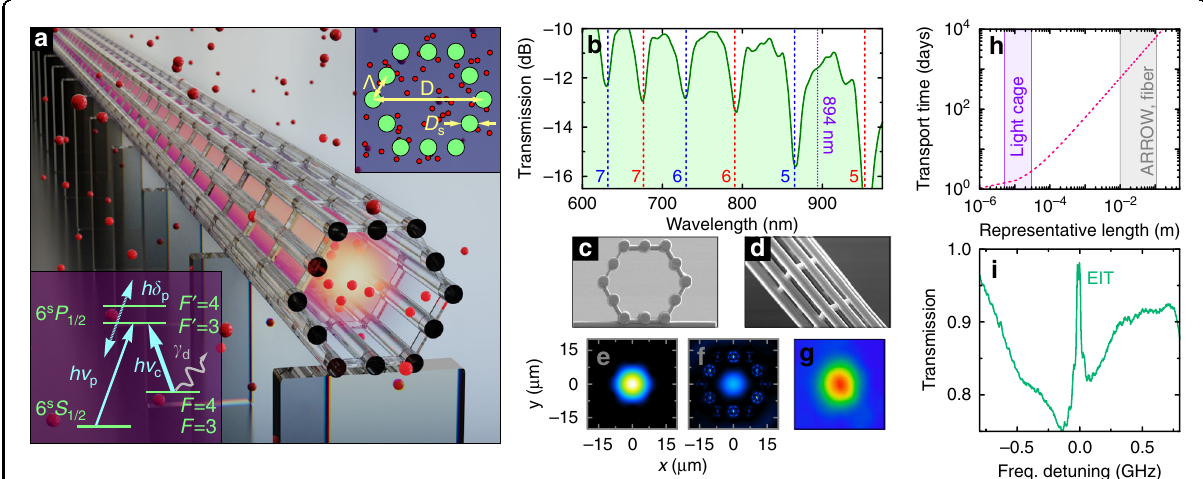
Fig. 1 Quantum-optically integrated light cage. a Sketch of the light cage (LC) enclosing a light beam (yellow) exposed to caesium (Cs) vapour (red spheres). Bottom inset: EIT Λ -scheme with probe ( ν p ) & coupling fi elds ( ν c ) and coherence dephasing γ d of the F = 4 hyper fi ne state. Top inset: cross section of the LC geometry including design parameters ( D s = 3.6 μ m, Λ = 7 μ m, D = 28 µm, and 4.5 mm length). b Transmission spectrum of the Cs-cell-integrated LC in the visible – near-infrared with the Cs-D1 line (894 nm) in a leaky mode between cut-off frequencies of isolated strand modes 38,39 (dashed lines, blue: LP 0x , red: LP 1x ). c Scanning-electron microscopic image of the LC front facet. d Side view of the sample, showing open spaces between strands. Simulated spatial fi eld distributions, e within a transmission band (894 nm) and, f near a resonance (930nm). g Measured output fi eld pattern. h Improvement of fi lling time, revealed by plotting the transport time versus representative length. Three orders of magnitude faster fi lling is provided by the LC compared to capillary-type waveguides. (Details in Supplementary Section II.) i Example of a measured EIT